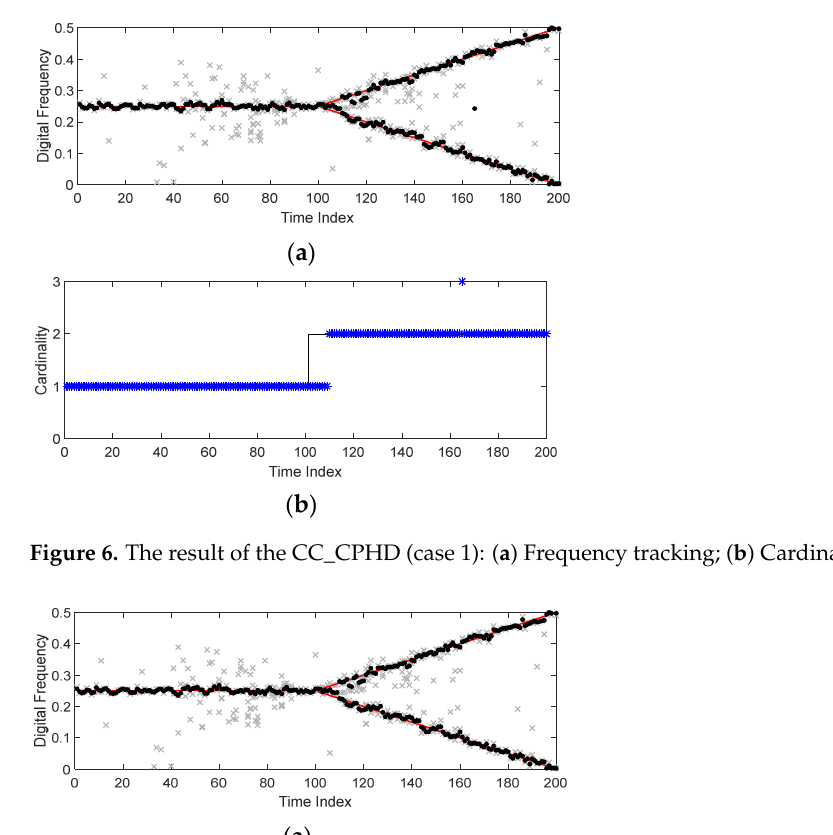
Figure 5. The result of the FCM_CPHD (case 1): ( a ) Frequency tracking; ( b ) Cardinality estimate.